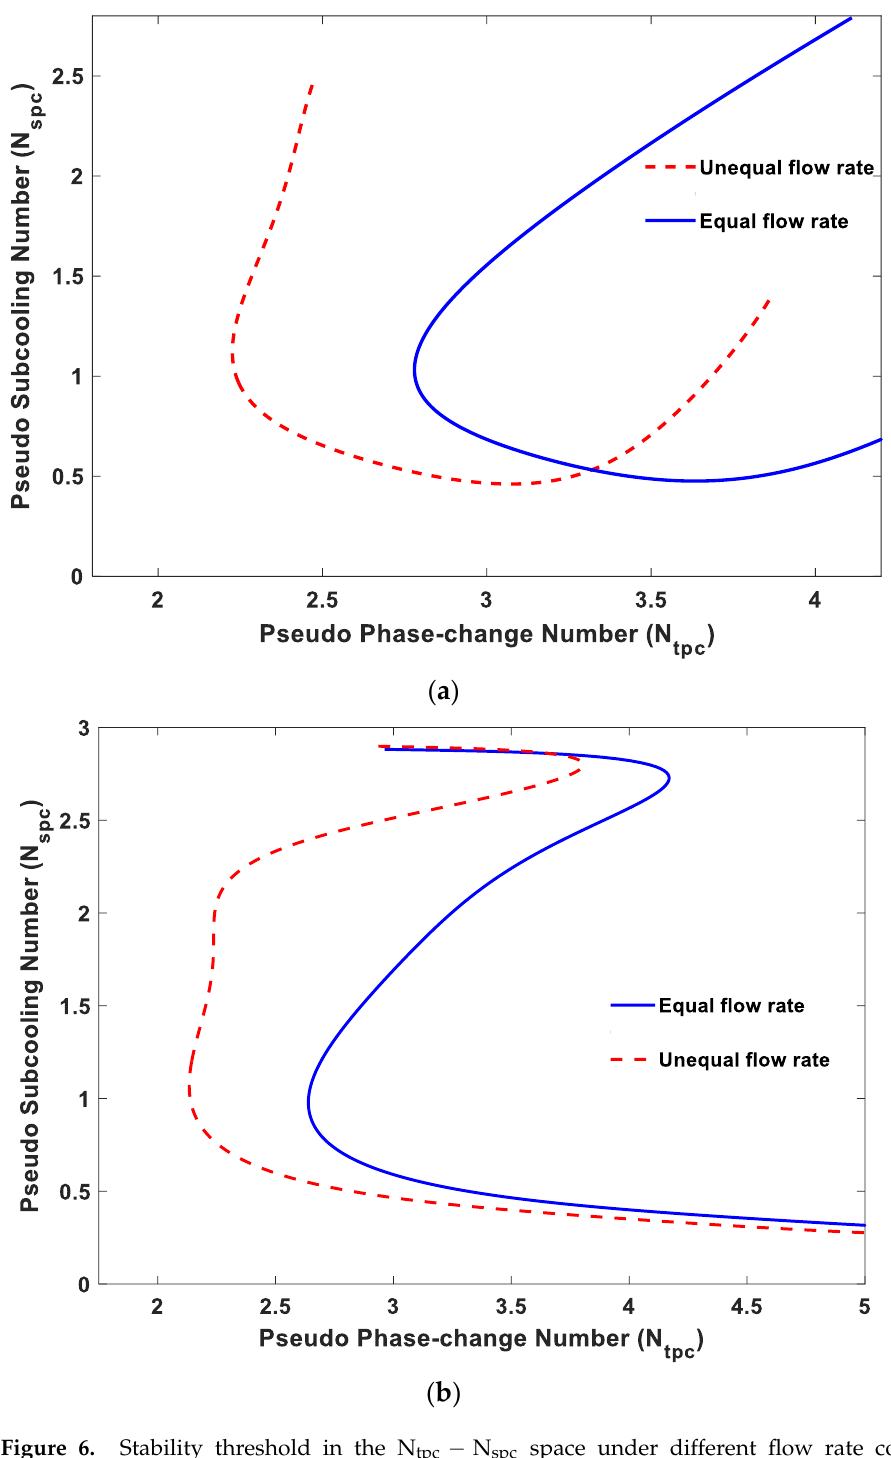
Figure 6. Stability threshold in the N tpc − N spc space under different flow rate conditions. ( a ) Su- percritical water (H 2 O) . ( b ) Supercritical carbon dioxide (CO 2 )